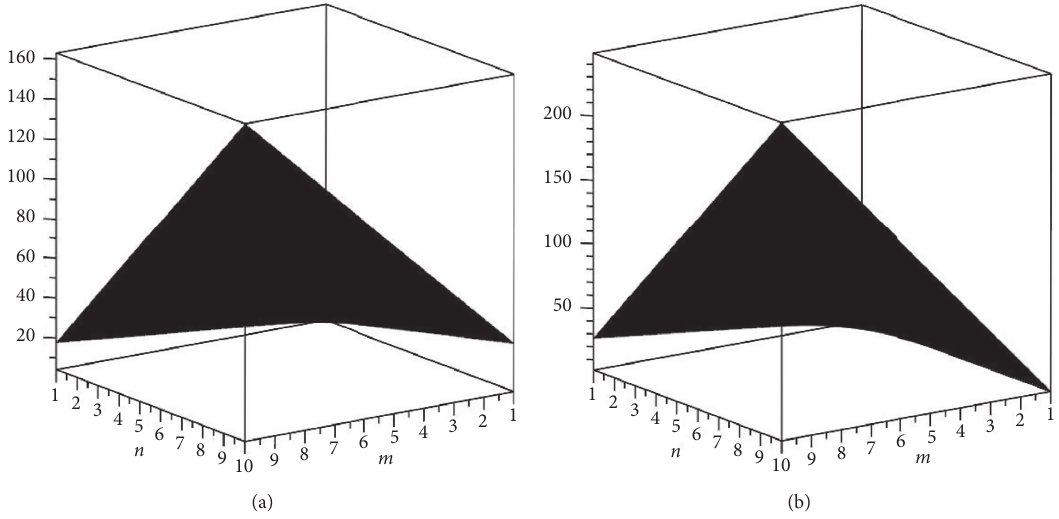
Figure 7: (a) The harmonic Index. (b) The sum-connectivity index.